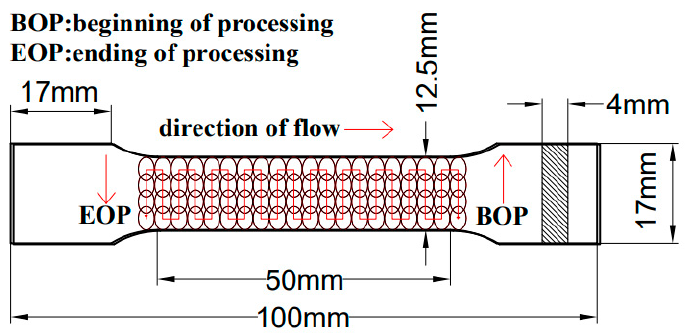
Figure 2. Schematic diagram of FGH95 standard tensile sample dimension with the processing area and processing route.